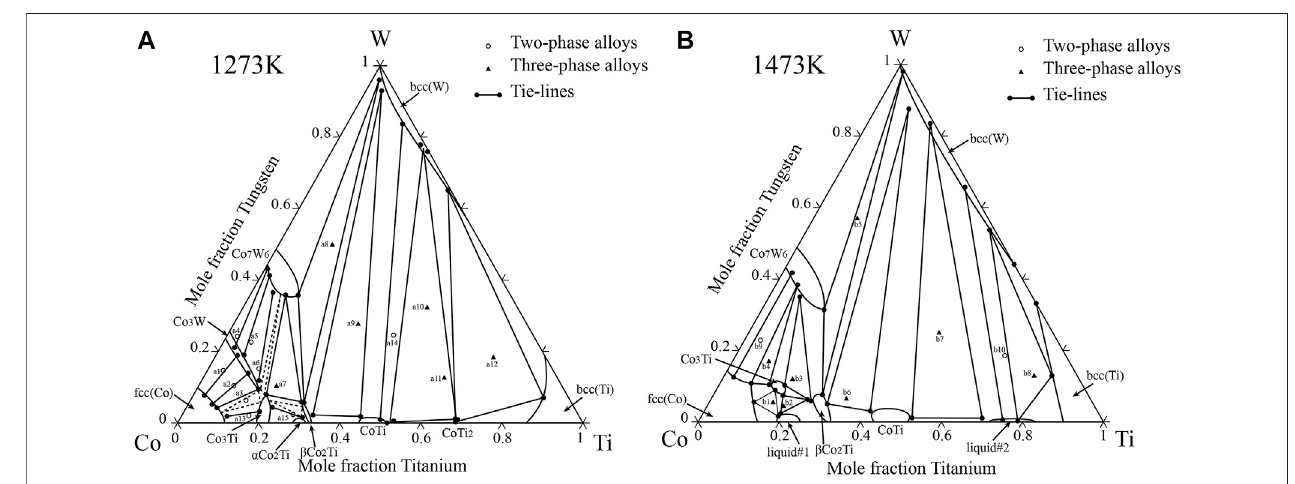
FIGURE 11 | Isothermal sections of the Co – Ti – W system (A) at 1273 K and (B) at 1473 K